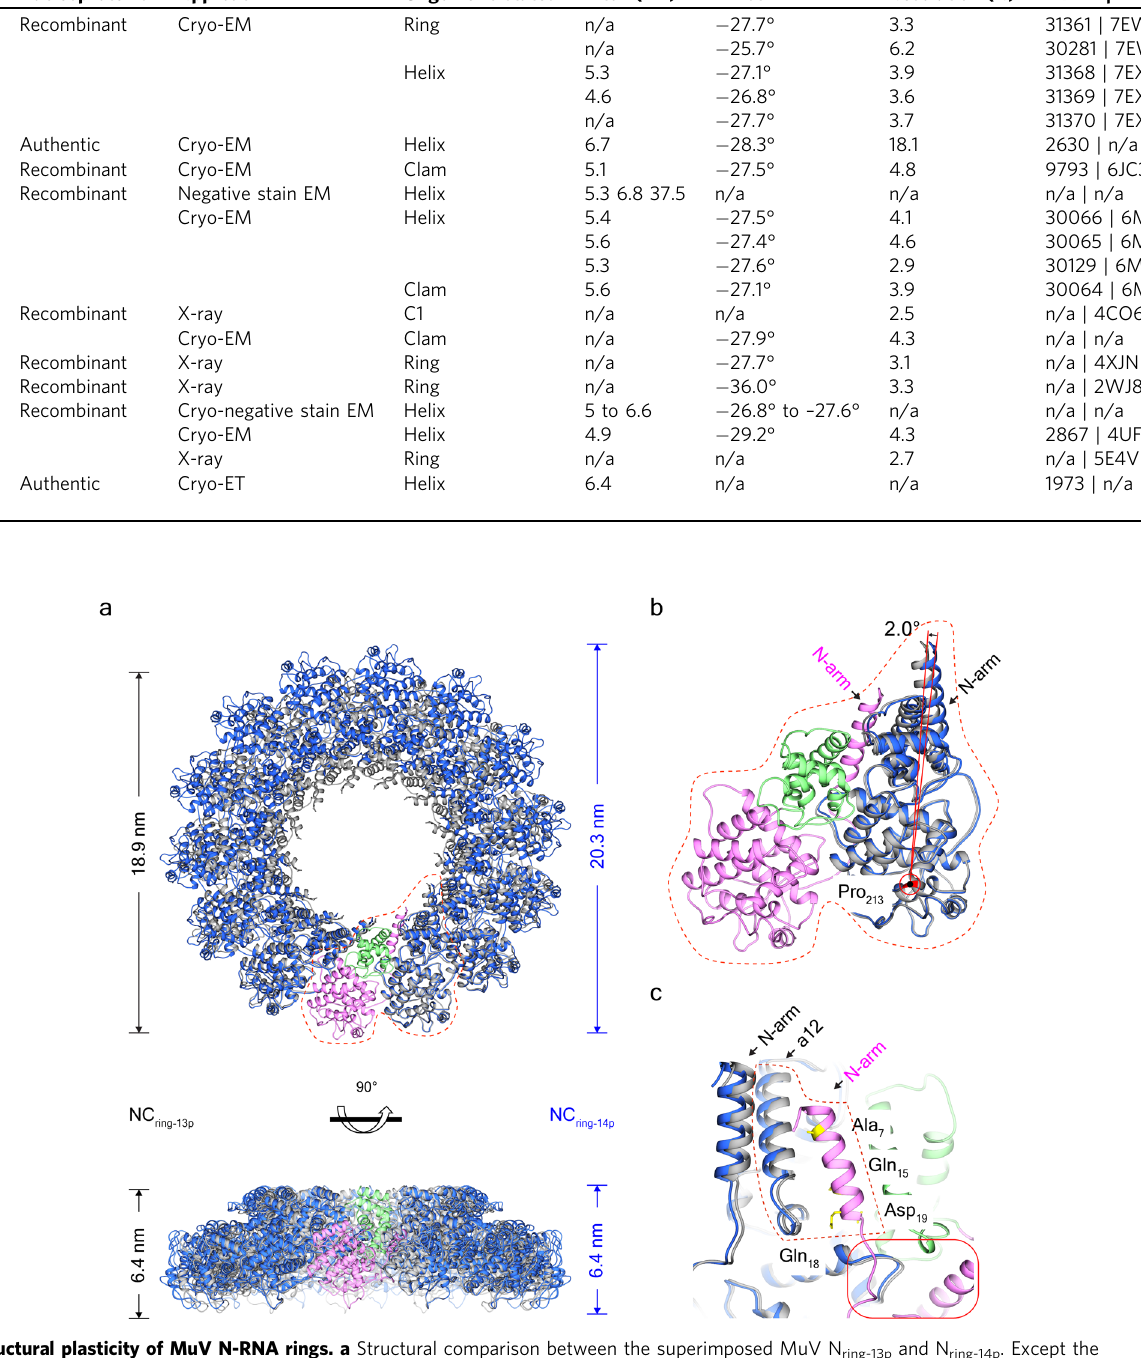
Fig. 2 Structural plasticity of MuV N-RNA rings. a Structural comparison between the superimposed MuV N ring-13p and N ring-14p . Except the superimposed protomers (the 1st, colored in pink), the other protomers in N ring-13p and N ring-14p are colored in gray and blue, respectively. Side views of N ring-13p and N ring-14p have the same height at 6.4 nm and share the same plane. b In-plane rotation of the 2nd protomer in the superimposed MuV N ring-13p and N ring-14p . c Slight interface change of N-arm and N-hole in the superimposed MuV N ring-13p and N ring-14p . The N-arm and the N-hole interfaces between neighboring protomers are marked in dashed and solid polygons,